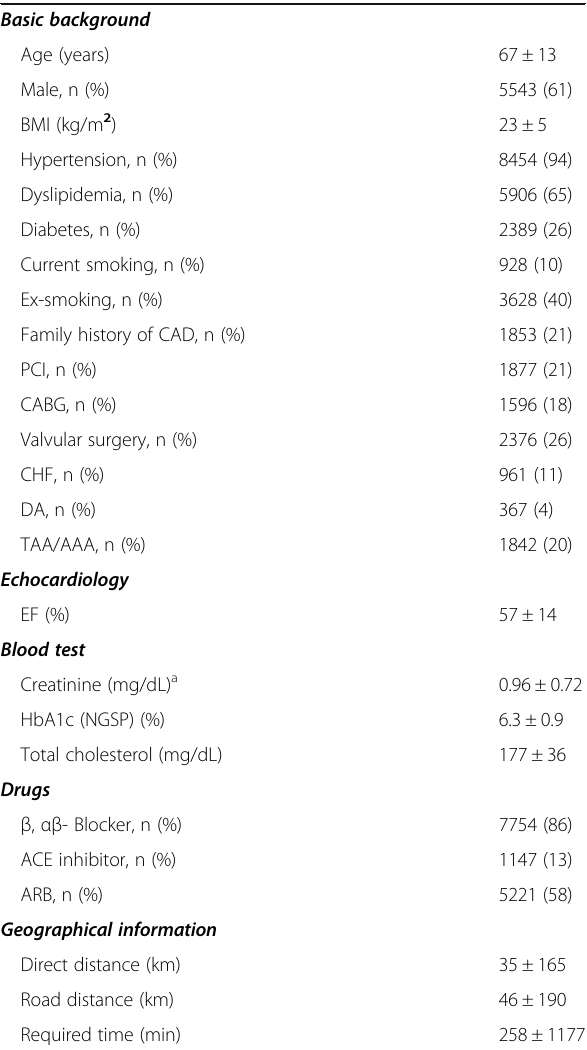
Table 1 Patient background Basic